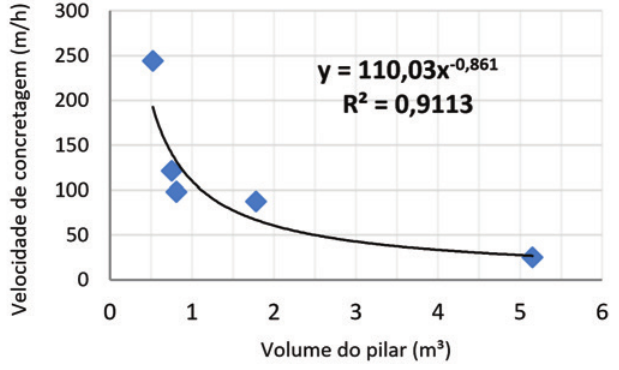
Figura 9 Relação entre velocidade de concretagem medida in loco e volume dos pilares Fonte : elaborada pelos